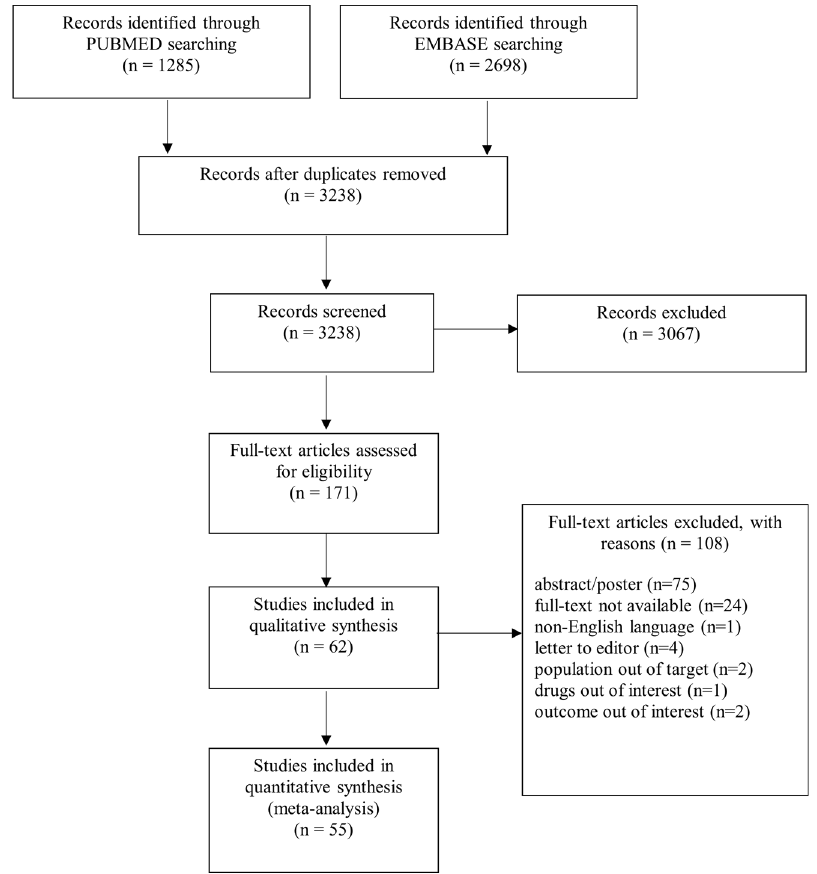
Figure 1. Flowchart of search.